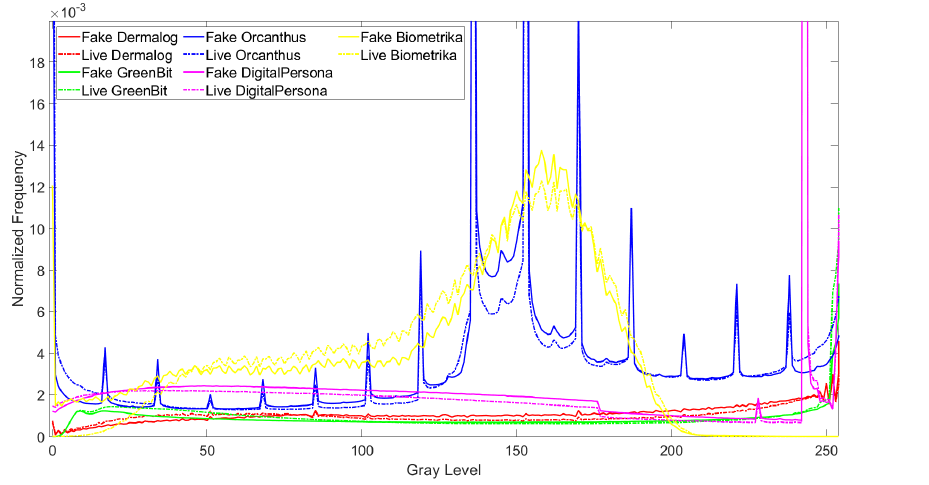
Figure 2. Mean histogram of grayscale for all the five considered